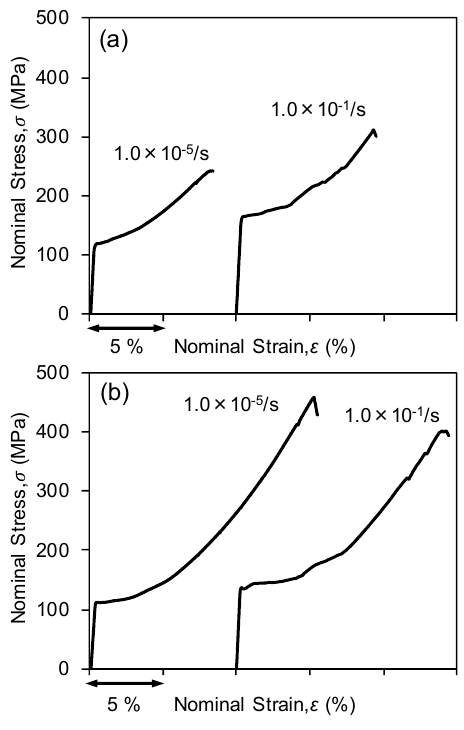
Figure 2. Stress–strain curves of SrTiO 3 single crystals with different chemical compositions, deformed at constant strain rates of ε = 1.0 × 10 − 5 (s − 1 ) and ε = 1.0 × 10 − 1 (s − 1 ). ( a ) Sr / Ti = 1.00, ( b ) Sr / Ti = 1.04 as the starting powders.